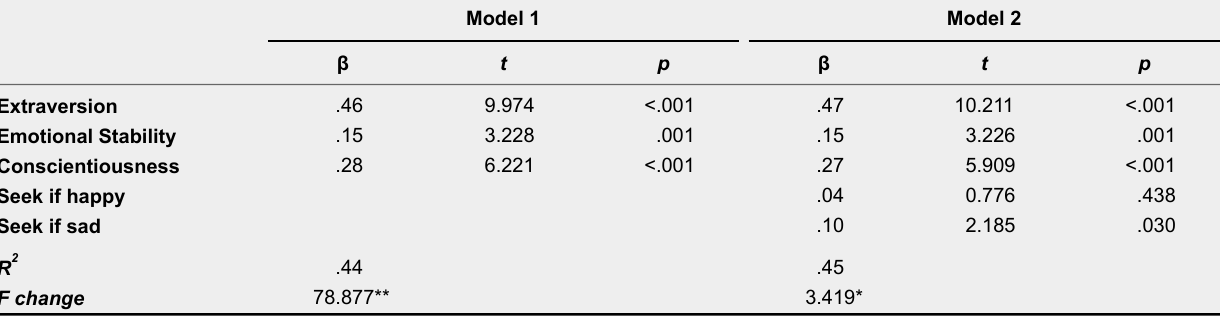
Hierarchical Multiple Regression of Positive Mood (PA) onto Personality and the Use of Nature for Emotion Regulation (Females, N = 313)